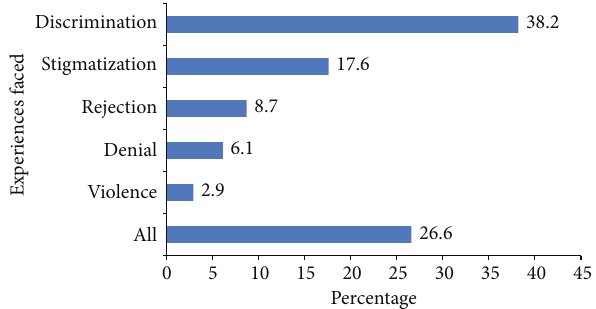
Figure 3: Experiences faced in their daily interaction as